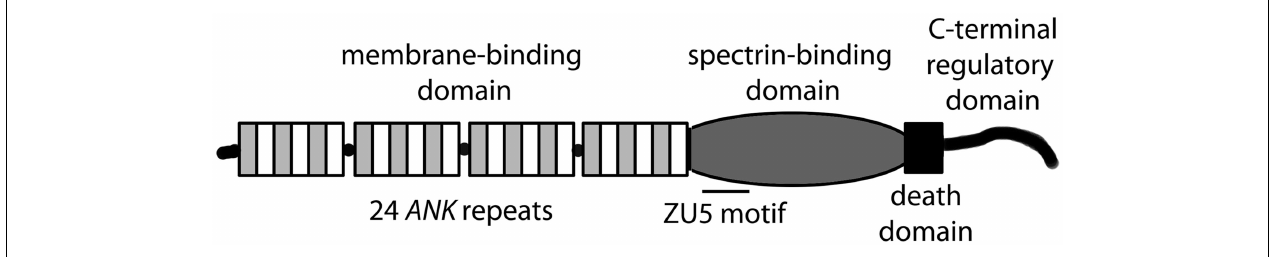
FIGURE 1 | Canonical ankyrin (R, B, G) domain organization.